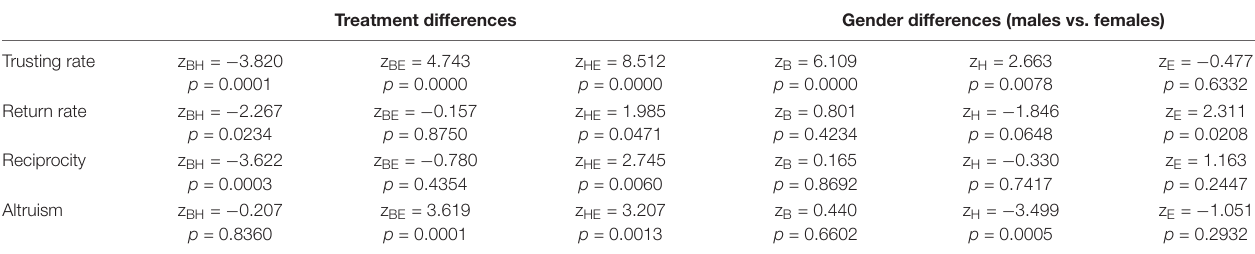
TABLE 6 | Testing treatment and gender effects on TG decisions. Treatment differences Gender differences (males vs. females)